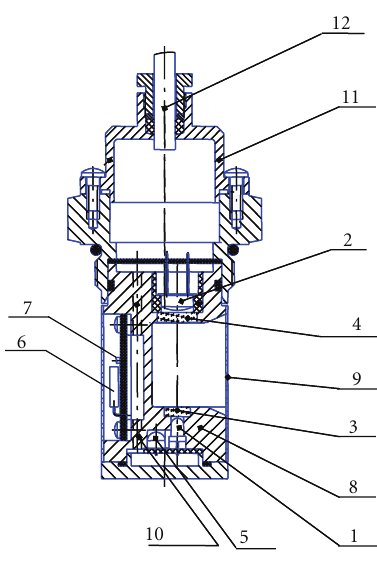
Figure 2: Probe for chromatic parameter device ((1): white LED, (2): RGB color sensor, (3,4): optical window, (5): feedback diode, (6): water sensing element, (7): temperature sensing element, (8): housing, (9): protective mesh, (10): electrical wires, (11): pre- amplifier PCB, (12): connecting cable).